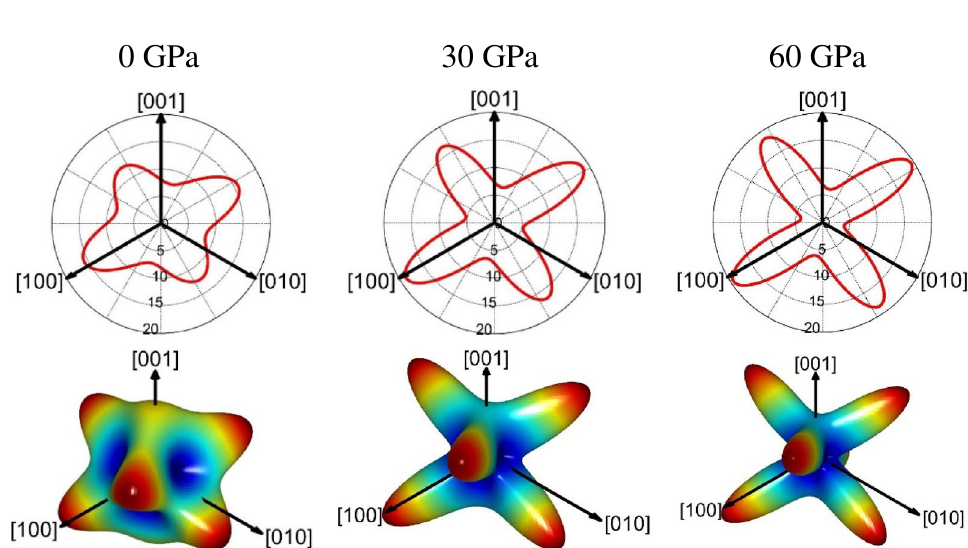
Figure 9. 3D spatial distribution and its projection of hardness for magnesite at various